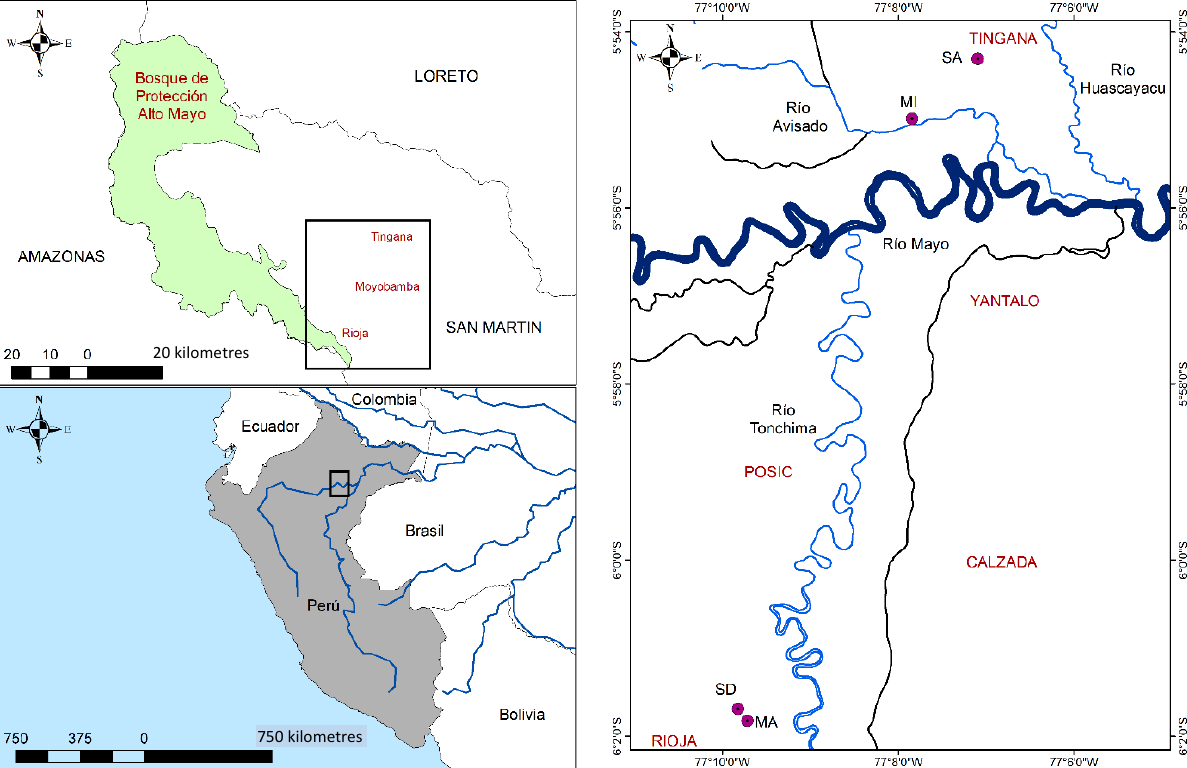
Figure 1. Geographical locations of the four studied palm peat swamp forests in the two localities Tingana (SA, MI) and Posic (SD, MA) of the Alto Mayo Valley, San Martín,